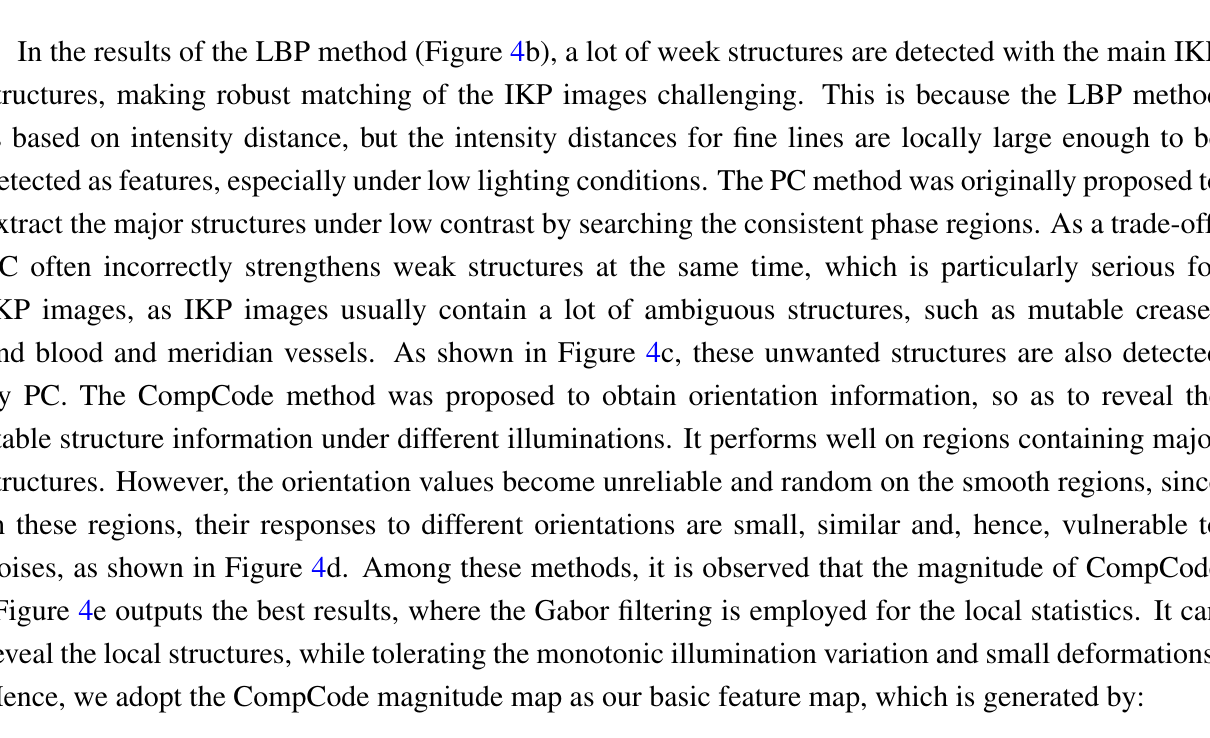
Figure 4. Existing feature detectors used for IKP images. ( a ) The IKP images under two illumination conditions; ( b ) the local binary pattern (LBP) maps; ( c ) the phase congruency (PC) maps; ( d ) the orientation; ( e ) the magnitude maps of